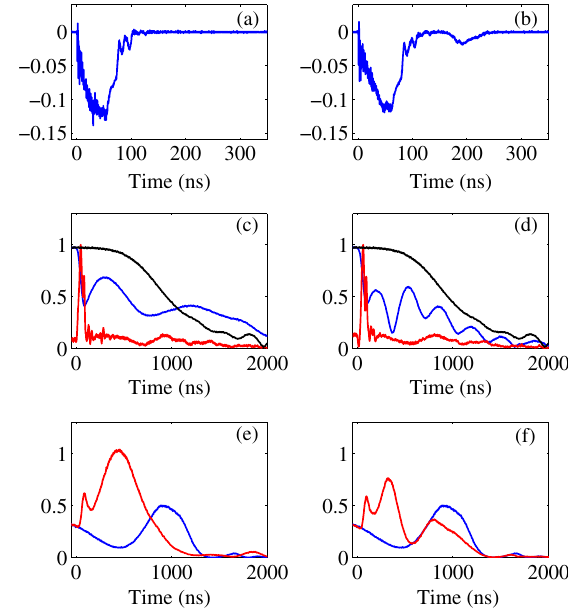
FIG. 4. Radio frequency breakdown with a laser trigger of a single-breakdown event (left) and multiple-breakdown event (right). (a),(b) The Faraday cup signal in amperes. (c),(d) Nor- malized FFTamplitude of the pickup signal in different frequency bands as a function of time, including the fundamental mode without breakdown (black line), the fundamental mode with breakdown (blue line), and the 8.6 GHz HOM with breakdown (red line). (e),(f) Normalized FFT amplitude of the reflection signal, including the fundamental mode without breakdown (blue line) and with breakdown (red